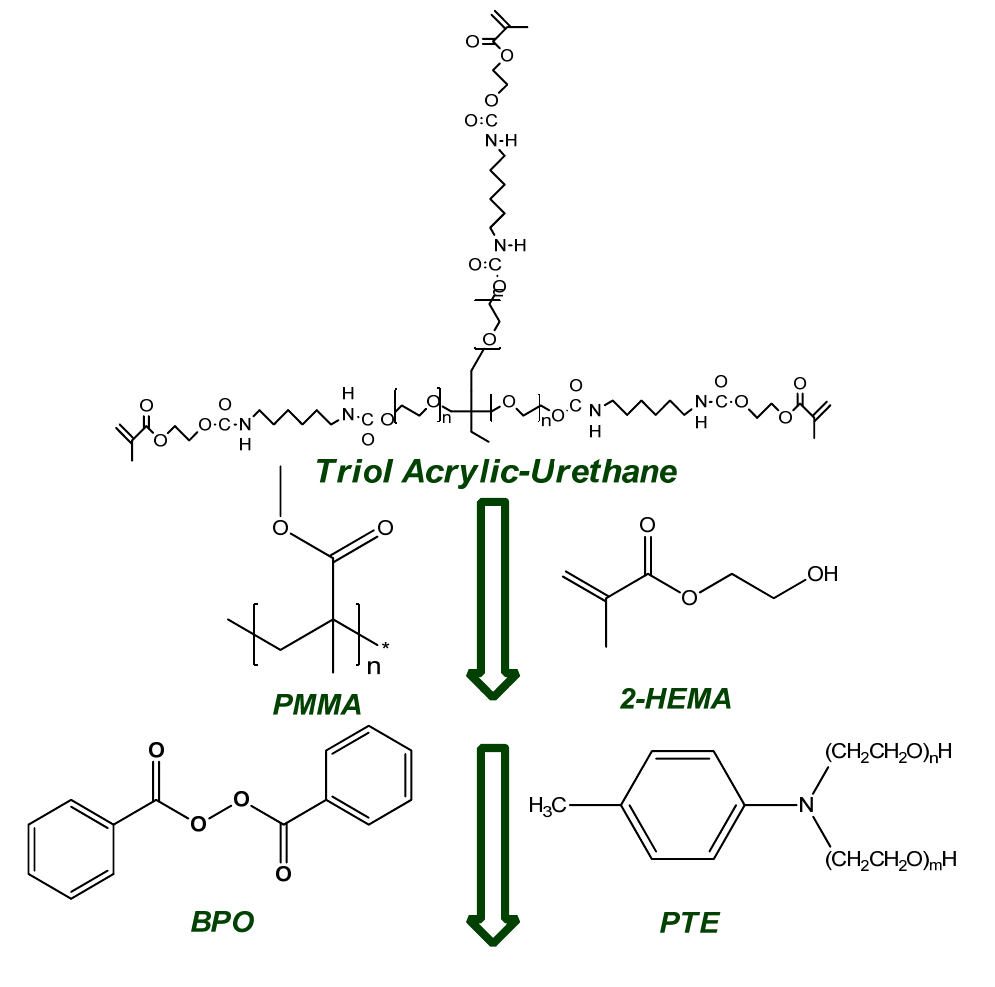
Table 1. Split composition of the comparative